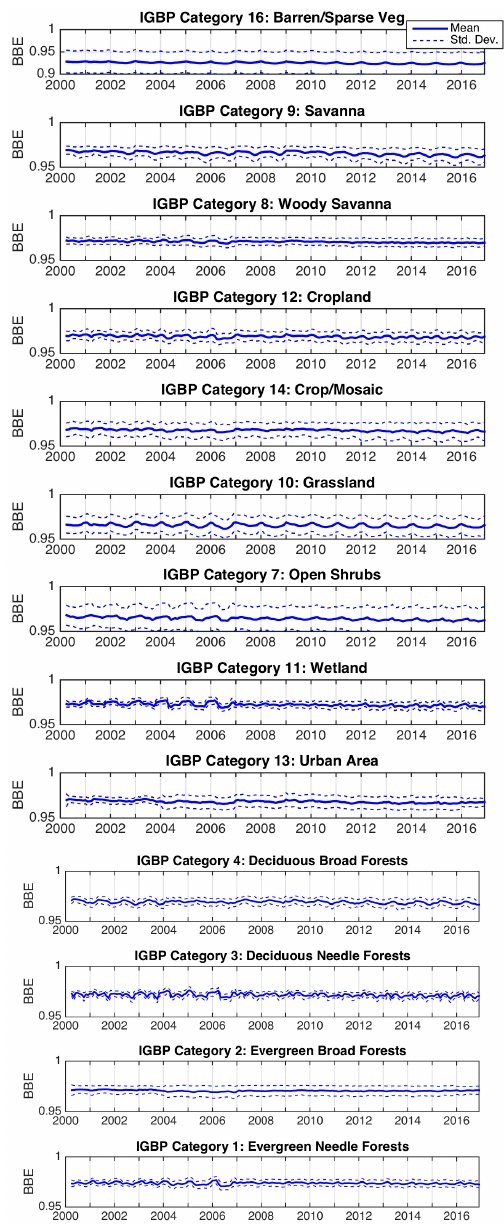
Figure 8. Time series of CAMEL 8.0–13.5 µm BBE statistics by IGBP land cover classifications. Note the y -axis limit is different for the top panel.